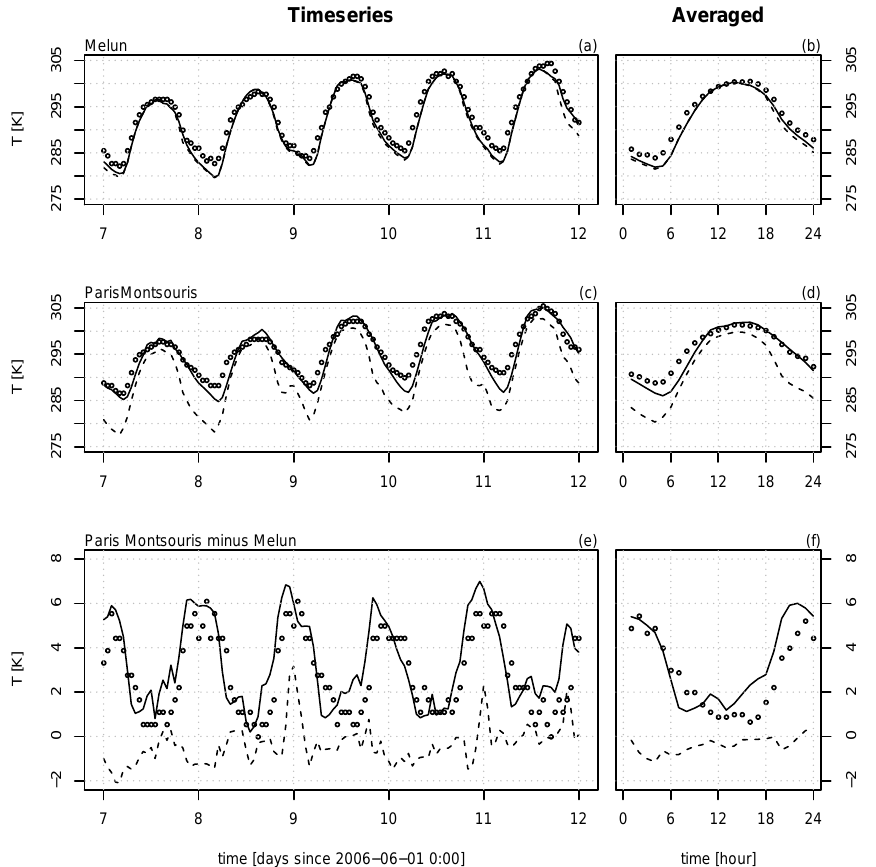
Fig. 5. The temperature time series for Melun (a) , Paris-Montsouris (c) , and the difference between the sites (e) , for the observations (circles), base run (full line) and scenario run (dashed line), and their hourly averaged diurnal cycle (b, d, f)